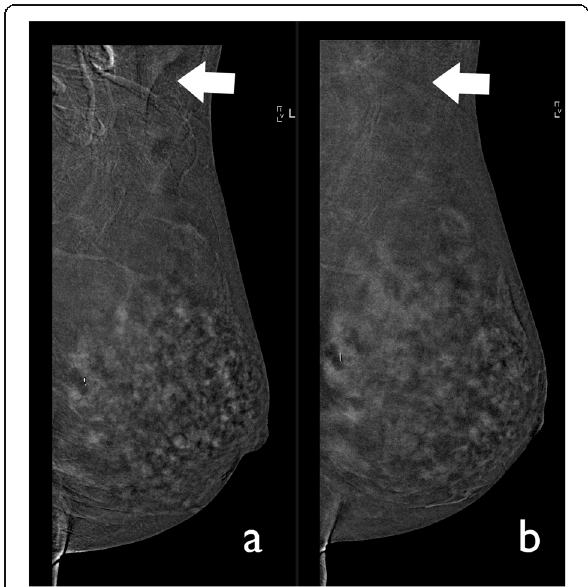
Fig. 2 Hair artefact. CEDM was performed for preoperative staging in a 51-year-old patient. a The recombined image shows several curvilinear lines related to the patient ’ s hair (arrow). b Thus, we asked the patient to tie her hair before performing another acquisition. The artefact is no longer visible